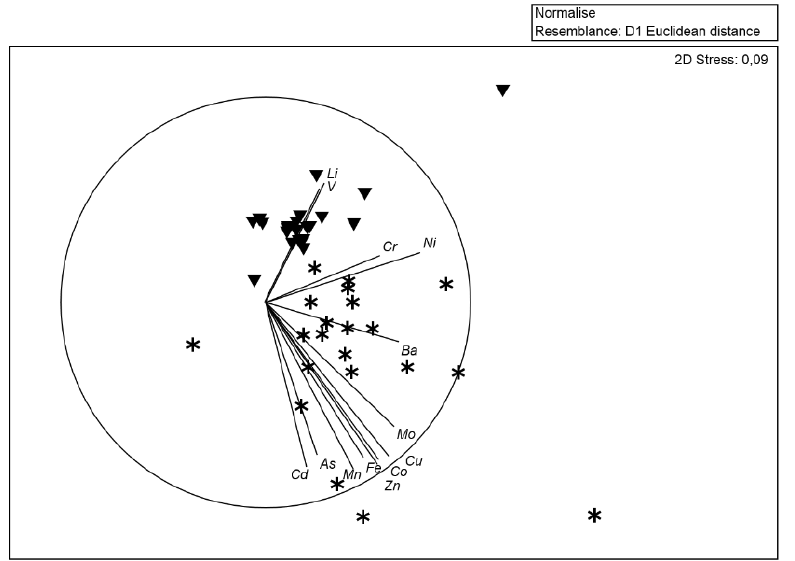
Figure 2. MDS plot of the elemental composition in two fractions of R. pulmo . Plot showing the discrimination among the umbrella ( (cid:72) ) and gonads ( * ) based on the elemental composition. Vectors are proportional to the Pearson correlation of the element concentration variables (r > 0.6).